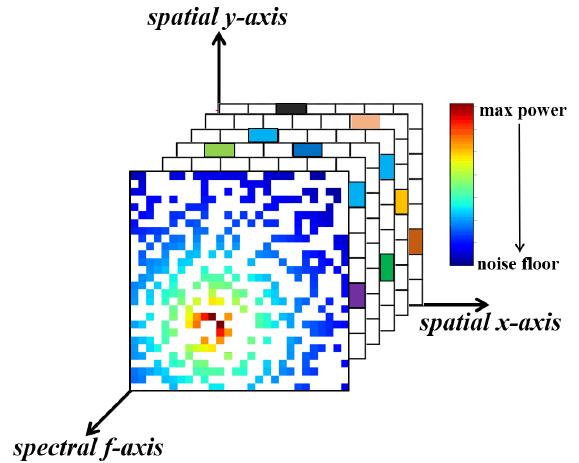
Figure 3. The colored, incomplete power spectrum